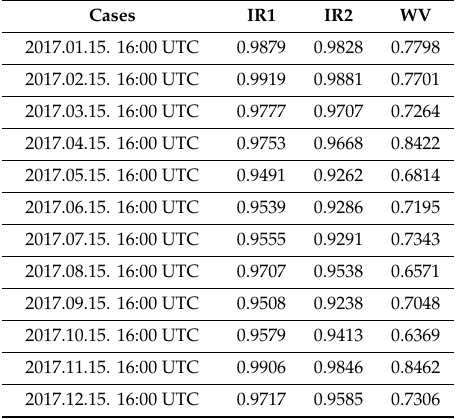
Table 4. Nighttime correlation coe ffi cients among the COMS MWIR, WV, IR1, and IR2 bands. Cases